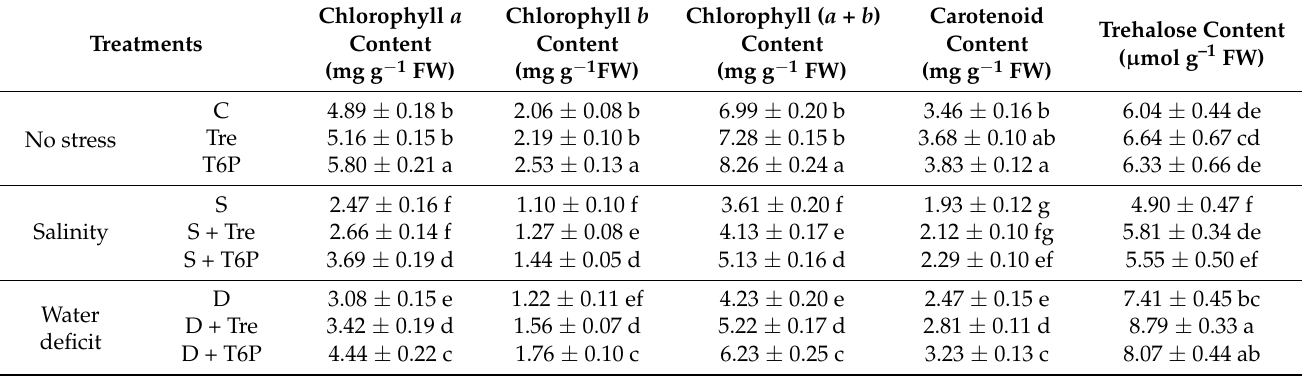
Table 2. Effect of trehalose and T6P on leaf chlorophyll a , chlorophyll b , chlorophyll ( a + b ), and carotenoid contents in mustard seedlings. Seedlings were grown in a hydroponic solution containing 200 mM NaCl for 10 days. For water deficit treatment, wheat seedlings were treated with 12% PEG for four days. Means were calculated from three replicates for each treatment, and the bars represent the standard deviation ( ± SD). Values with different letters are significantly different at p ≤ 0.05 by Fisher’s LSD